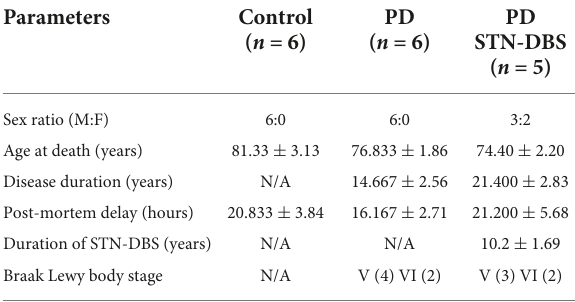
TABLE 1 Demographic and clinical characteristics of all cases